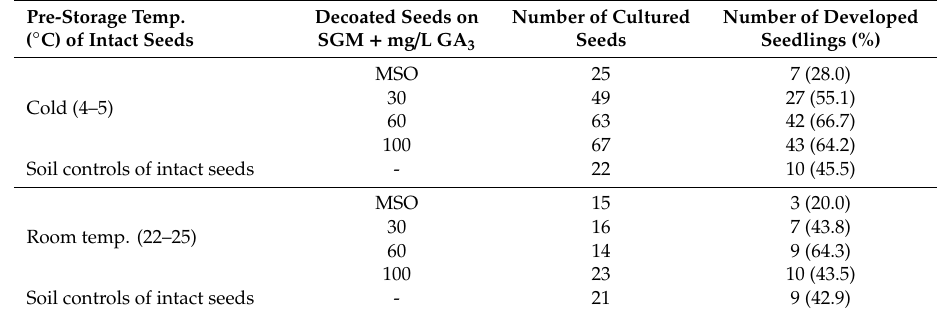
Table 3. E ff ect of storage temperature and gibberellic acid (GA 3 ) levels on the germination potential of M. autumnalis decoated seed cultures vs. intact seeds directly sown in potting soil